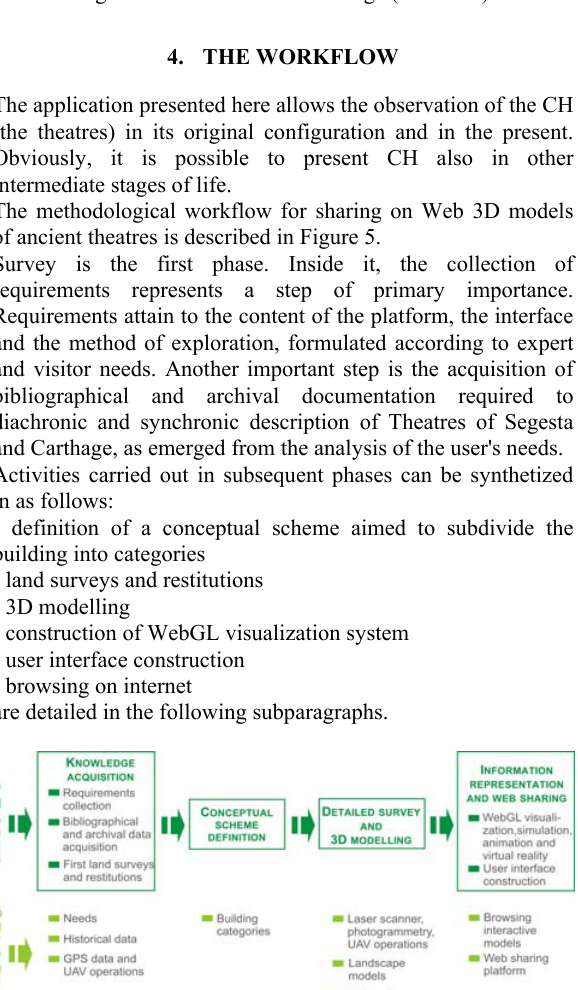
Figure 4. The Theatre of Carthage (real view)